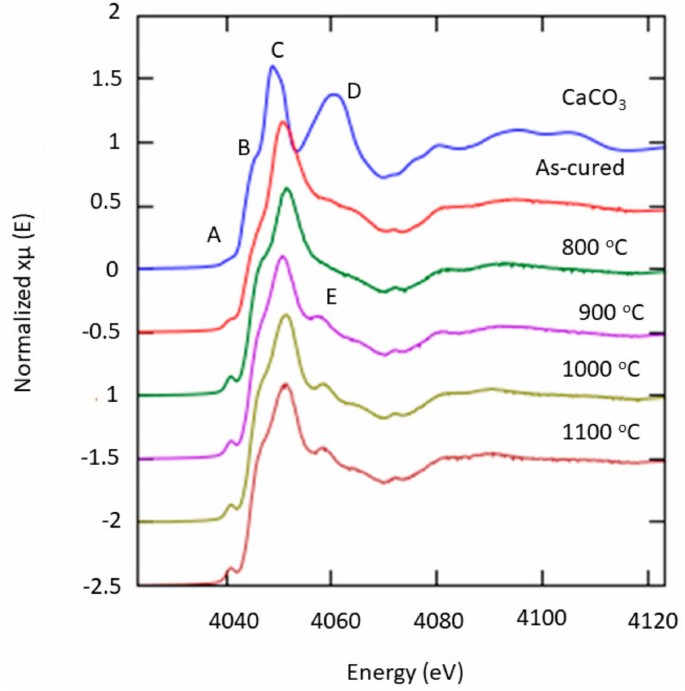
Figure 7. Normalized X-ray absorption near edge structure (XANES) spectra at the Ca K-edge: Comparison between before sintering samples and sintered kaolin–GGBS geopolymer at differ- ent